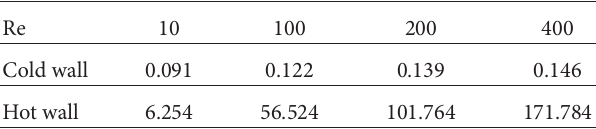
Table 4: Average Nusselt numbers at the hot and cold wall for different Reynolds numbers.